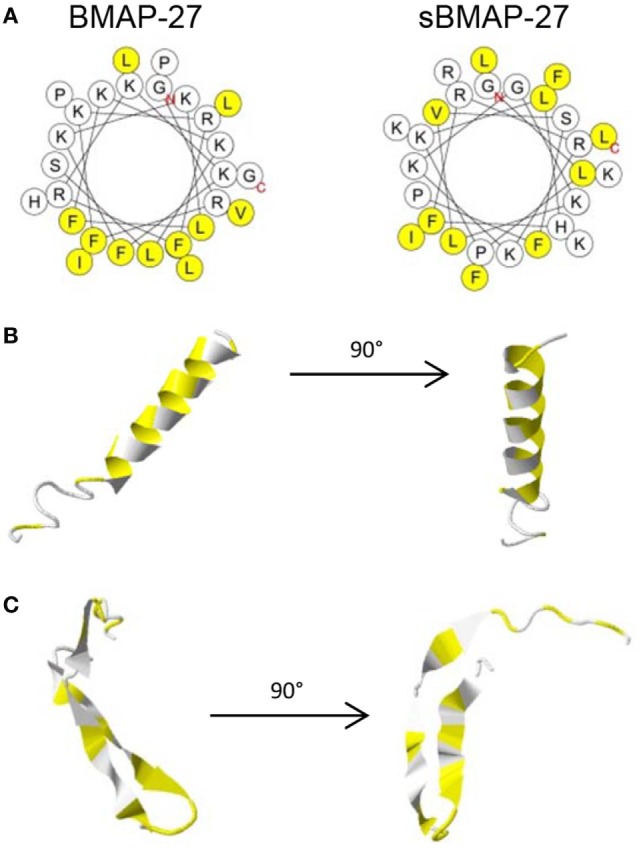
Predicted conformation of bovine myeloid antimicrobial peptide (BMAP)-27 and sBMAP-27. (A) Helical wheel projection of BMAP-27 and sBMAP-27. Hydrophobic residues are displayed in yellow, and the N- and C-terminal ends are depicted red. The helical projections were determined with HeliQuest. (B,C) Peptide ribbon of BMAP-27 (B) and sBMAP-27 (C) obtained by homology sequence comparison using I-Tasser. Hydrophobic portions are displayed in yellow. Arrows indicate a left side 90° rotation.